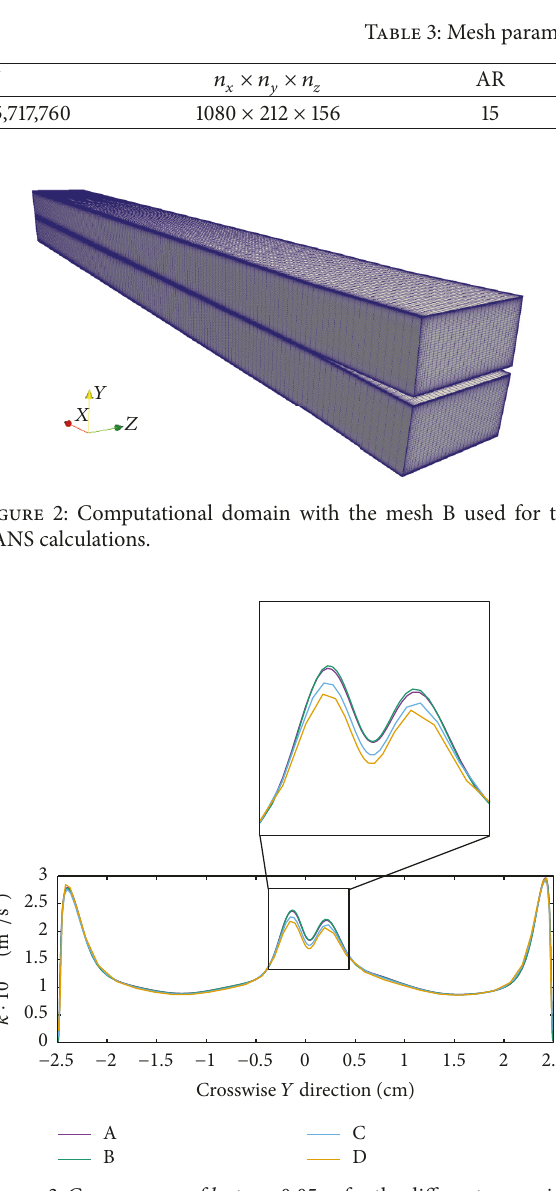
Figure 3: Convergence of 𝑘 at 𝑥 = 0.05 m for the different numerical meshes.